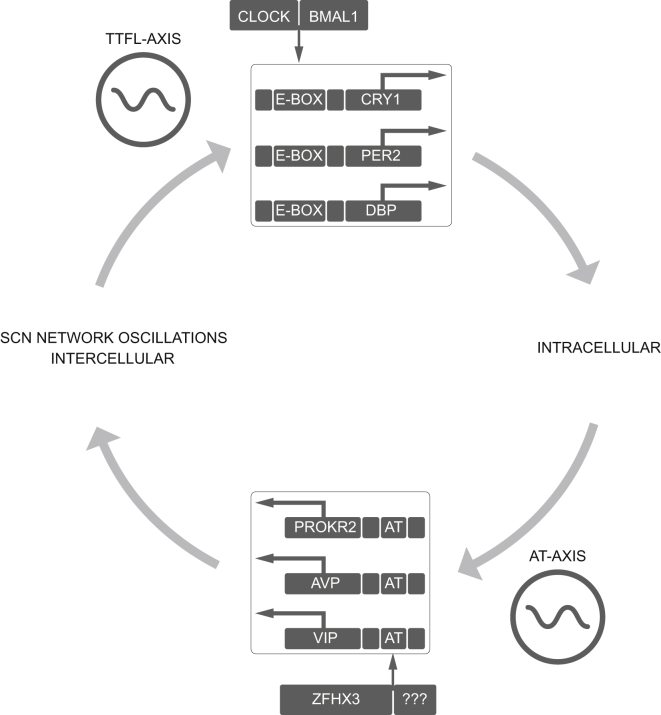
Model Depicting the Role of the ZFHX3/AT Axis in Maintaining SCN OscillationsA diagram outlining the proposed mechanism for maintaining robust circadian oscillations in the SCN. The ZFHX3/AT axis is sensitive to the TTFL and, in turn, feeds back temporal information to the TTFL through its neuropeptidergic-dependent effects on intercellular, circuit-level signaling.